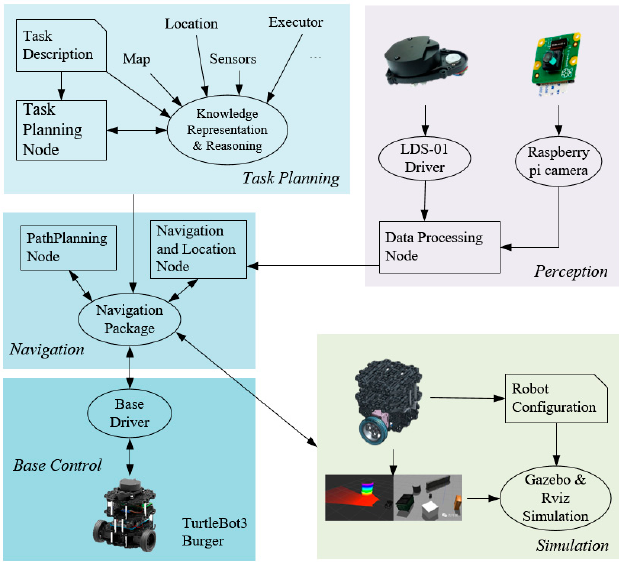
Figure 14. The framework of the software system.